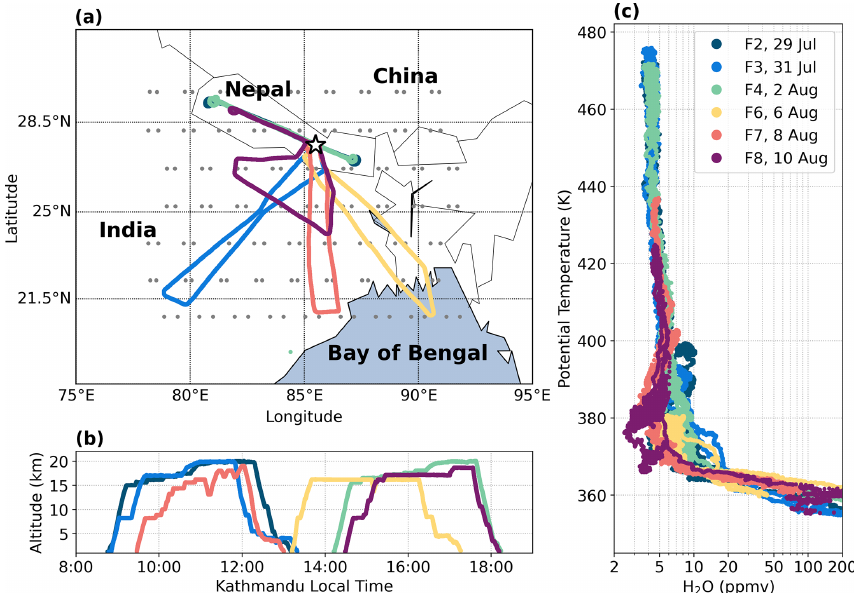
Figure 1. (a) Map of the ASM region with flight tracks overlaid in solid colored lines. Balloonsonde launch point (Dhulikhel, Nepal) is shown with the star symbol, and locations of MLS v5 profiles are shown as grey dots. The aim of flight F6 was to measure the convective outflow from a typhoon that had occurred in the days prior, and the outflow was reaching the very edge of the aircraft’s range over the Bay of Bengal on 6 August. F8 was specifically sampling a very local strong convective storm over India. (b) Altitude flight profiles are shown in local Kathmandu time. Flights F2, F3, and F7 took place during the morning, while F4, F6, and F8 occurred during the afternoon during which there is generally more active convection. F2–F4 included long legs at high altitude above the tropical tropopause layer (TTL) for the remote sensing instruments. F7 was targeting the detailed structure of the TTL and included several V-shaped profiles in the later half of the flight. (c) Profiles of H 2 O measured by FLASH against potential temperature for each of the six flights (F2–F4,